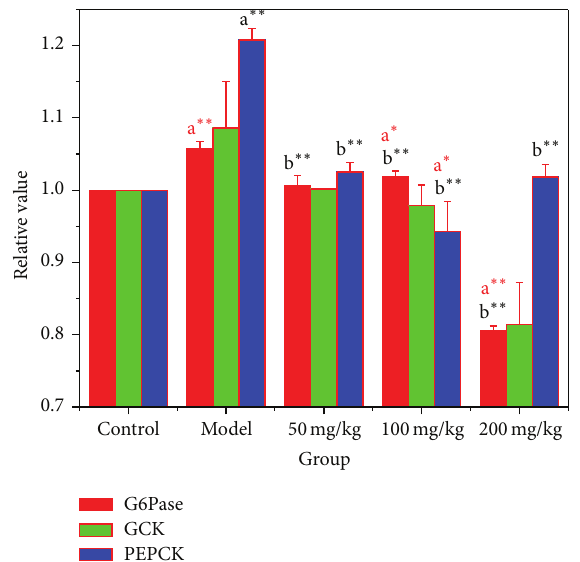
Figure 6: The effect of HuSang 32 branch bark extract on STZ- induced diabetic mice G6Pase, GCK, and PEPCK mRNA expres- sion. a ∗ , compared with normal control group, 𝑃 < 0.05 , significant difference; a ∗∗ , compared with normal control group, 𝑃 < 0.01 , very significant; b ∗∗ , compared with model group, 𝑃 < 0.01 , very significant.